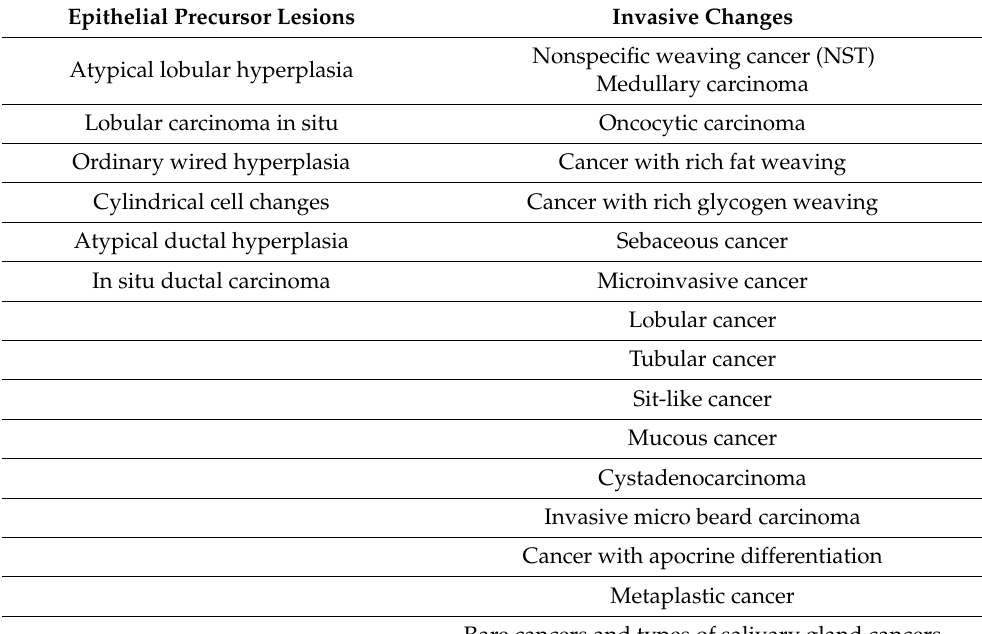
Table 2. Epithelial precursor lesions and invasive lesions of the mammary gland